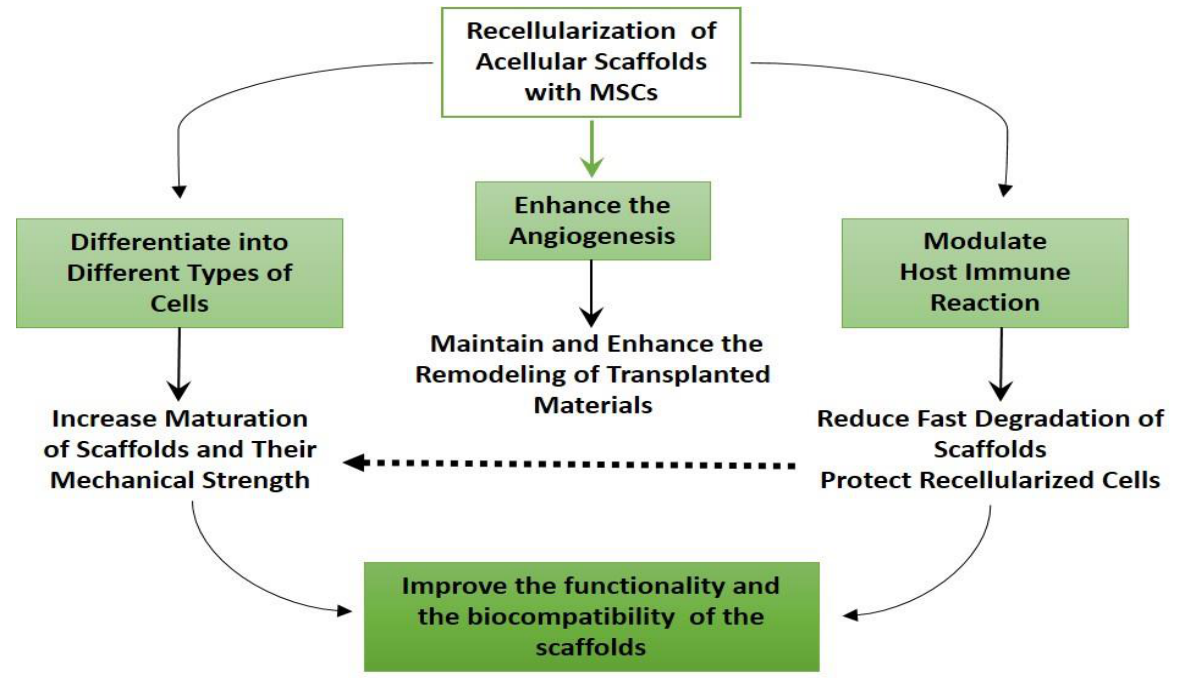
Figure 1. The roles of MSCs in scaffoldmediated regeneration.